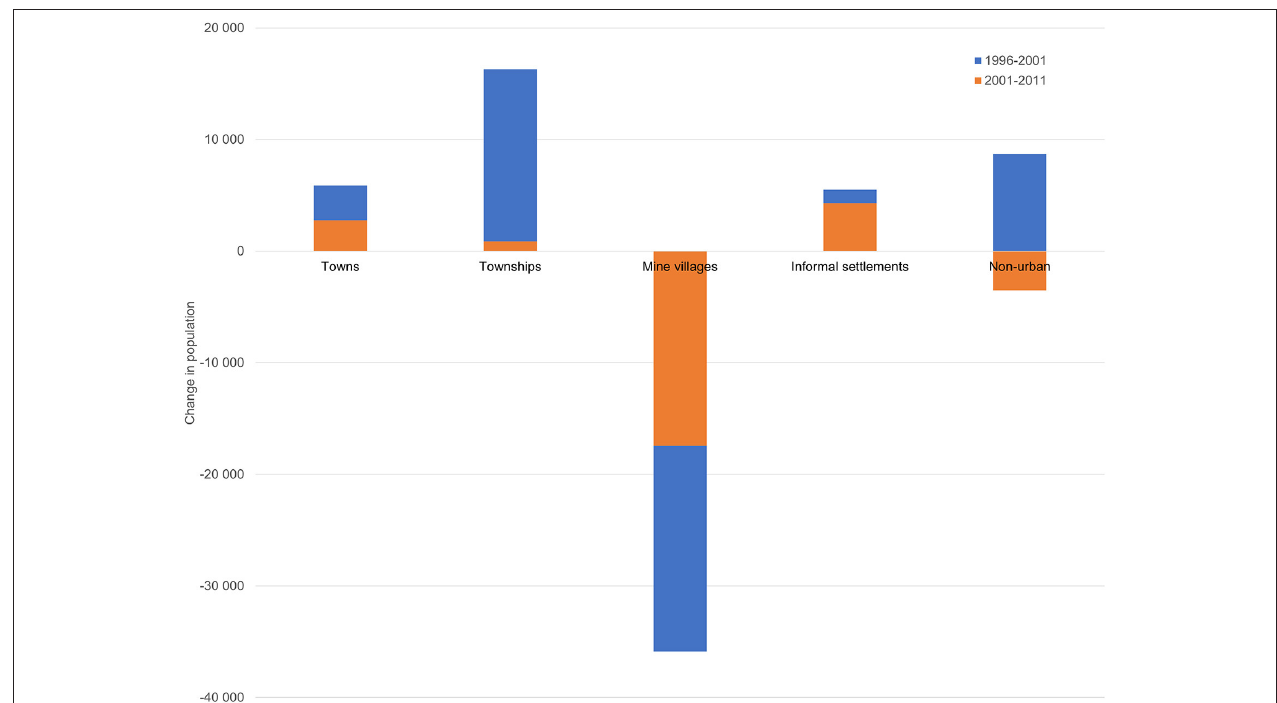
FIGURE 3 | Change in population in Merafong City Local Municipality from 1996 to 2001 and 2001 to 2011 (data sources: StatsSA, 1998, 2003,